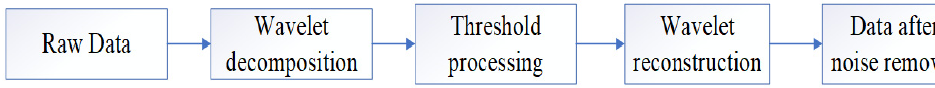
Figure 5. Wavelet denoising process.